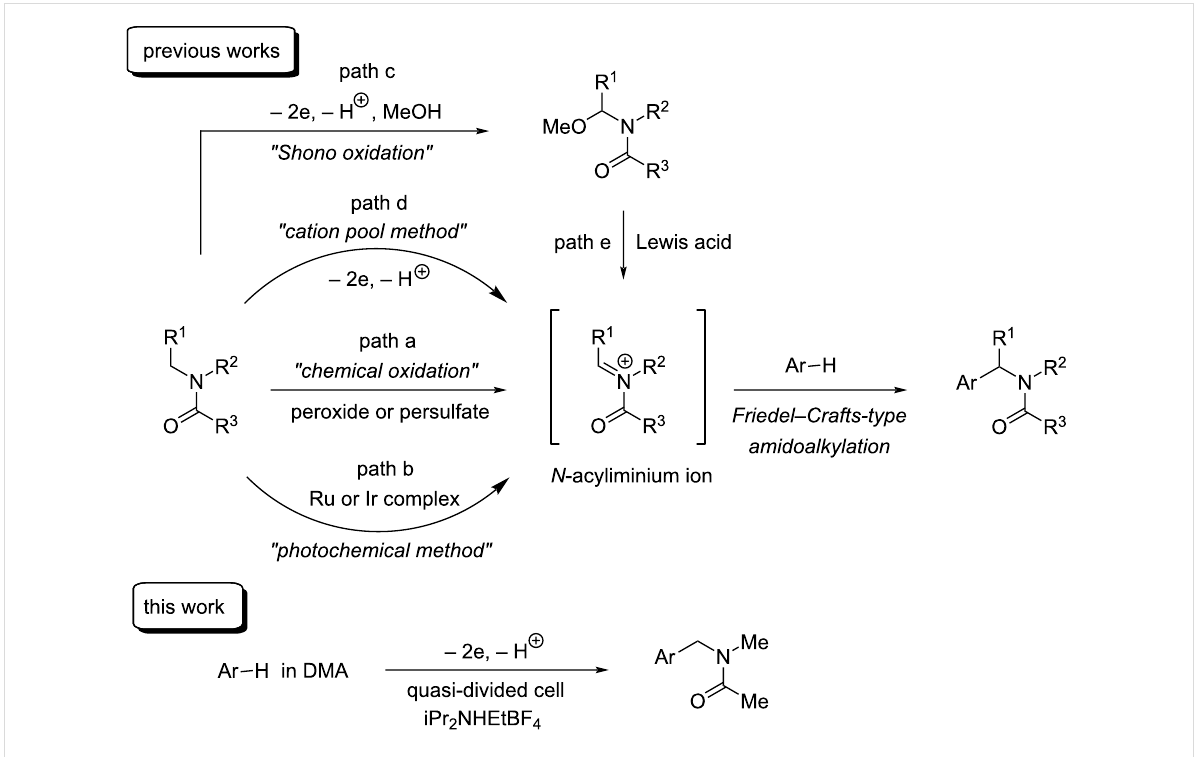
Scheme 1: Generation of N -acyliminium ion: previous and present